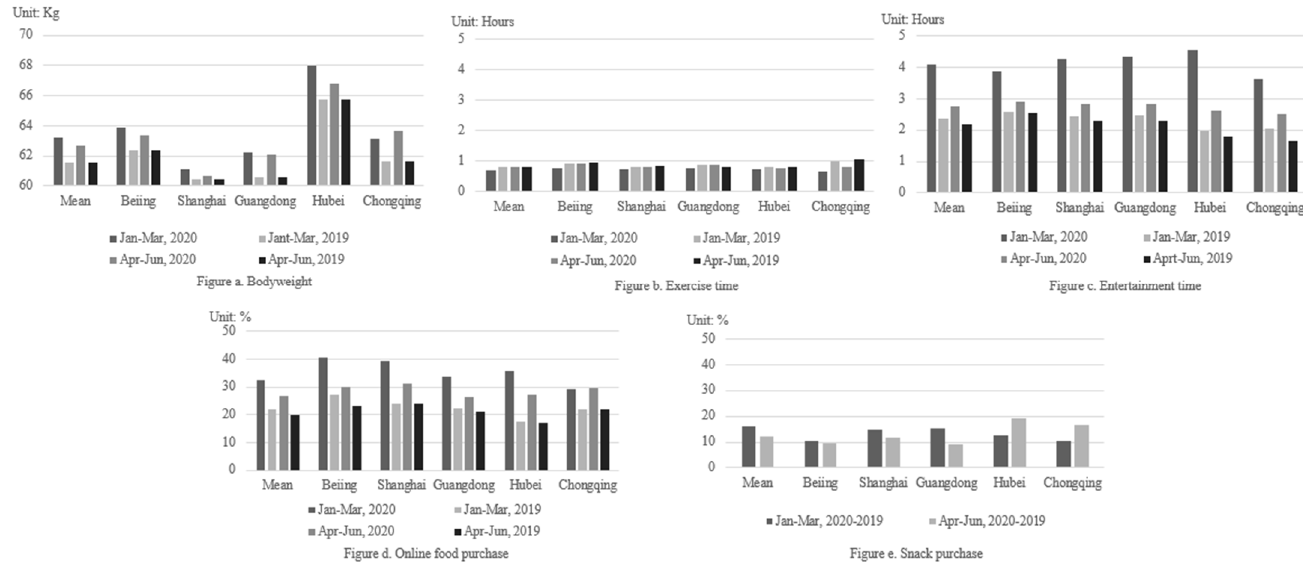
Figure 1. Trend in bodyweight ( a ), exercise time ( b ), entertainment time ( c ), online food purchase ( d ) and snack purchase ( e ) during COVID-19.